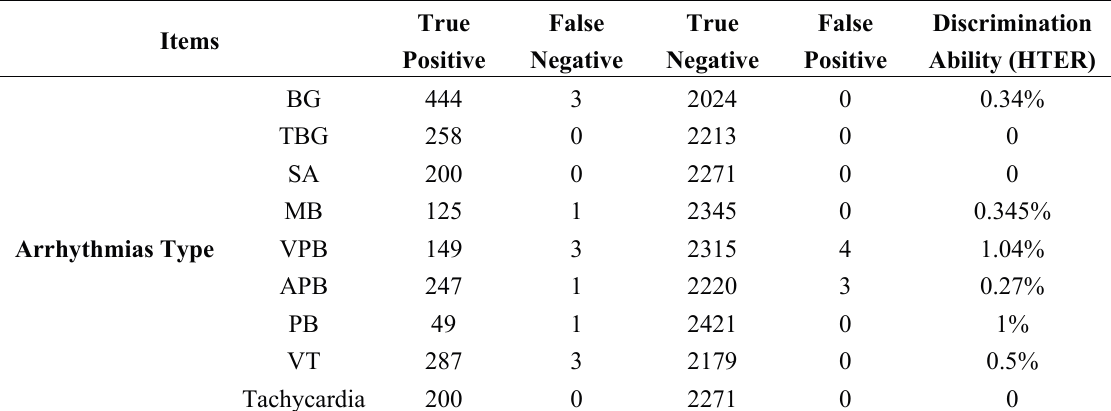
Table 10. Discrimination ability of the proposed